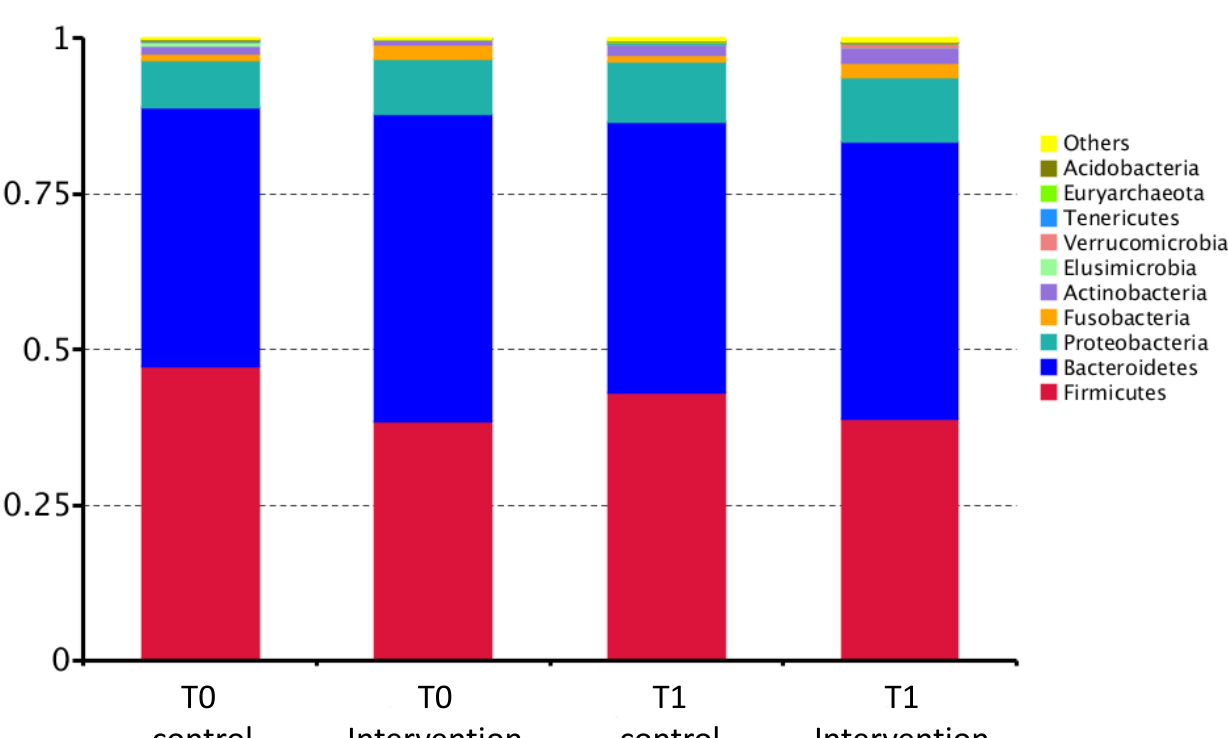
p -Value (Unadjusted)